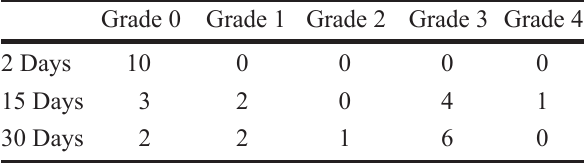
TABLE 1 - Classi fi cation of perivascular lung rejection (A) Grade 0